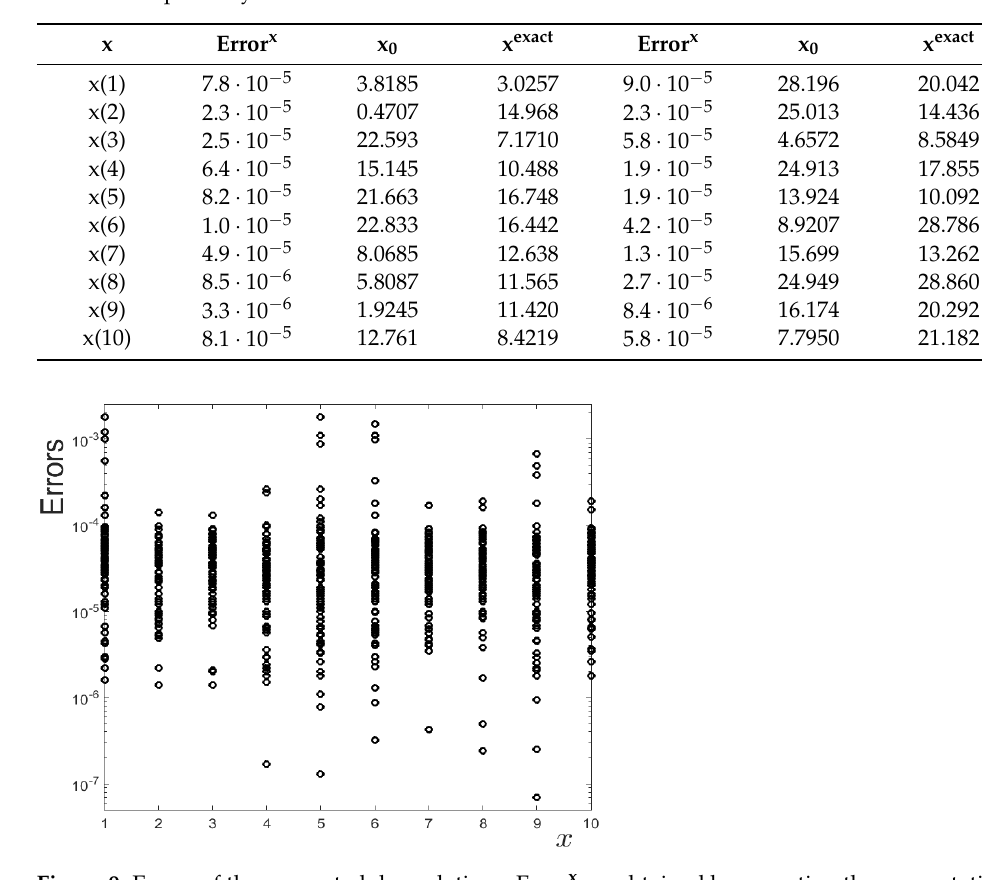
Figure 9. Errors of the computed degradations, Error x , as obtained by repeating the computations displayed in Table 10 one hundred times, with randomly chosen exact degradations and initial conditions for the adapted Newton